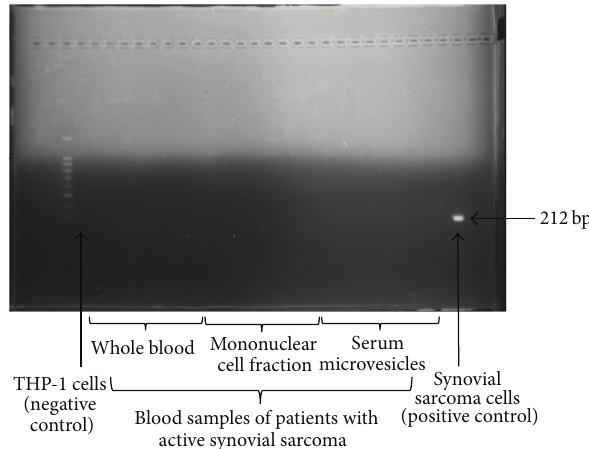
Figure 7: Analysis of the presence of the SYT-SSX fusion gene in whole blood, the mononuclear cell fraction, and serum microvesi- cles of synovial sarcoma patients by nested PCR. THP-1 cells: negative control. 1273/99 synovial sarcoma cells: positive control, showing the SYT-SSX fusion gene transcript (212bp; the primers were designed to amplify both SYT-SSX1 and SYT-SSX2 subtypes [20]).